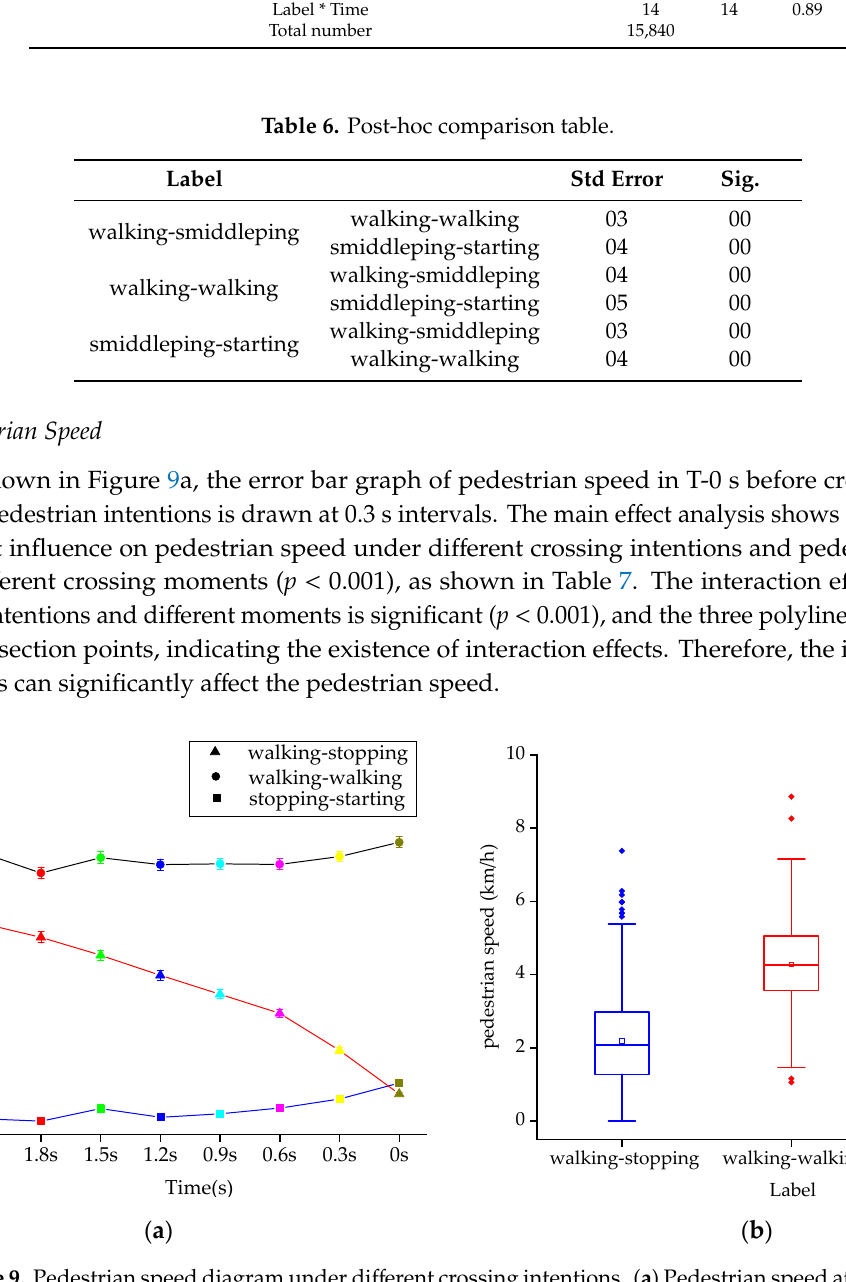
Figure 9. Pedestrian speed diagram under di ff erent crossing intentions. ( a ) Pedestrian speed at di ff erent times and with di ff erent intentions. ( b ) Mean pedestrian speed under di ff erent intentions. Table 7. Main effect test table.